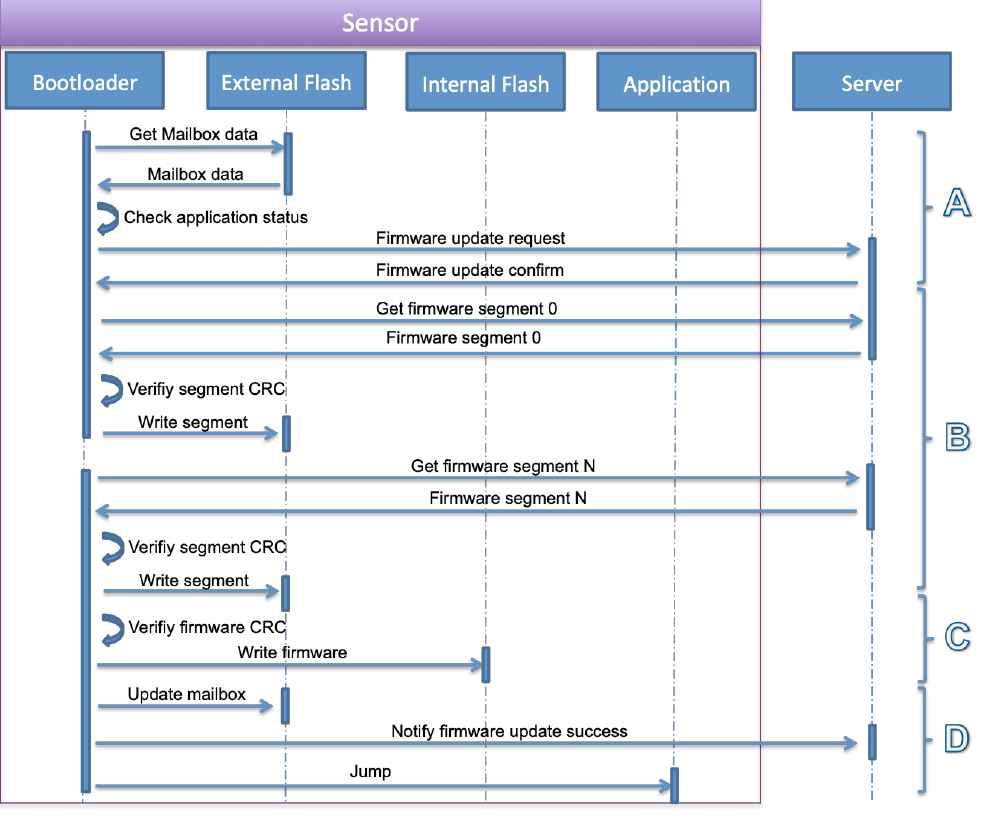
Figure 8. Bootloader firmware update